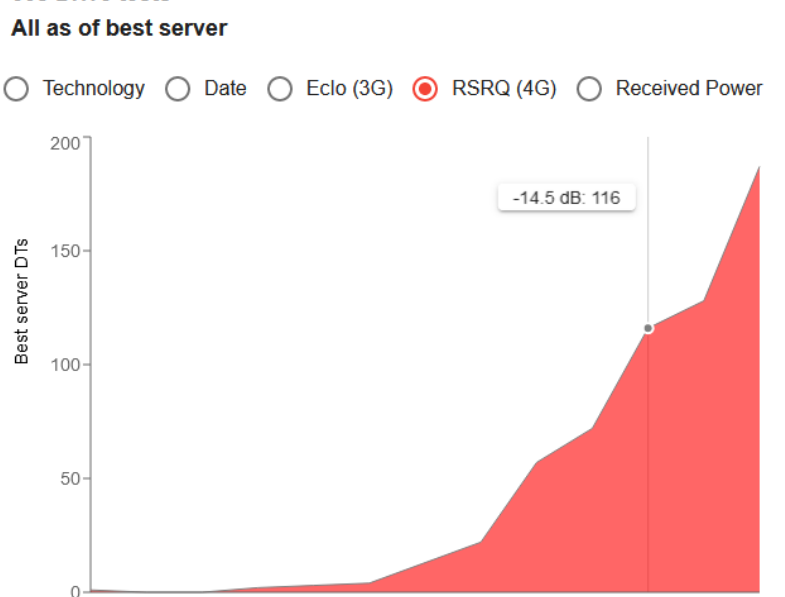
Figure 12. Histogram of the RSRQ with respect to the interest area DT.